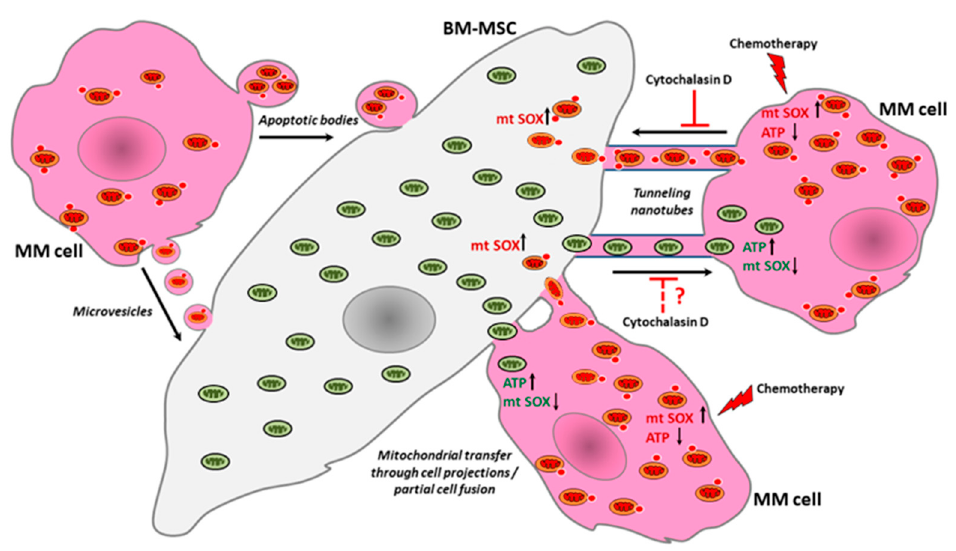
Figure 8. Mechanisms of bidirectional mitochondrial transfer between bone marrow stromal cells and myeloma cells. Bidirectional mitochondrial transfer occurs between autologous primary BM-MSCs and myeloma cells through MM cell- derived tunneling nanotubes. By inhibiting TNT formation by cytochalasin D, mitochondrial transfer is significantly reduced from MMs to BM-MSCs, but the incorporation of BM-MSC-derived mitochondria by myeloma cells continues through MM cell-derived cell projections after the fusion of cell membranes. MMs are unable to incorporate BM-MSC-derived MVs and hence mitochondria. In contrast, BM-MSCs incorporate large amounts of MM cell-derived mitochondria as a consequence of concentrated MV treatment, but this phenomenon is not decisive at physiological cell ratios in co-cultures. The incorporation of MM cell-derived mitochondria by BM-MSCs also occurs via endocytosis of MMs undergoing an early apoptotic phase or via the endocytosis of MM cell-derived apoptotic bodies induced by drug cytotoxicity. After chemotherapeutic drug treatment, independently from the type and mechanism of action of the drugs, BM-MSCs reduce the mortality of MMs, and, in parallel, the amount of BM-MSC-derived mitochondria increase in the surviving MMs. Transfer of functional mitochondria is accompanied with rise in ATP level and decrease in mitochondrial superoxide level in MMs. In parallel, there is also an increase in drug concentration-dependent mitochondrial transfer from MMs to BM-MSCs, increasing the level of free radicals in the stromal cells.